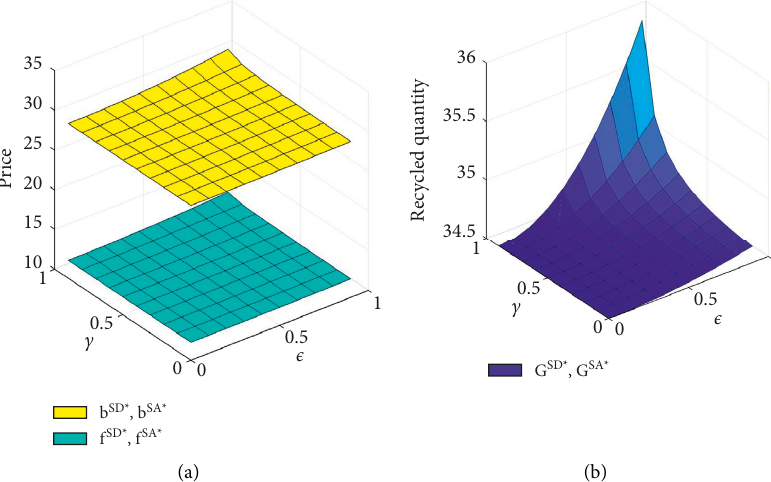
Figure 6: The effect of c and ϵ on product prices and quantity of recycled tires (a) the effect of c and ϵ on the recycling cost and the recycling price (b) the effect of c and ϵ on quantity of recycled